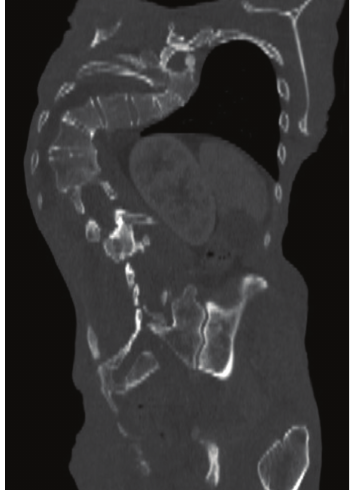
Figure 5: A 53-year-old man with neurofibromatosis type I. A morphostructural abnormality in the spine is characterized by significant dorsolumbar scoliosis with right convexity, as observed in his CT scan (coronal section).